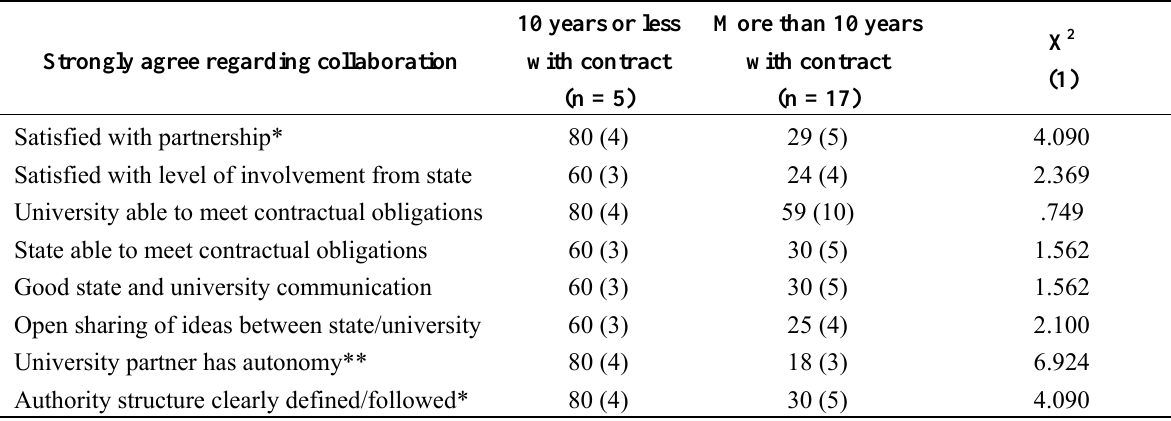
Table 6. Prevalence (%) of agencies reporting strong agreement to collaboration items by years with contract ( N =